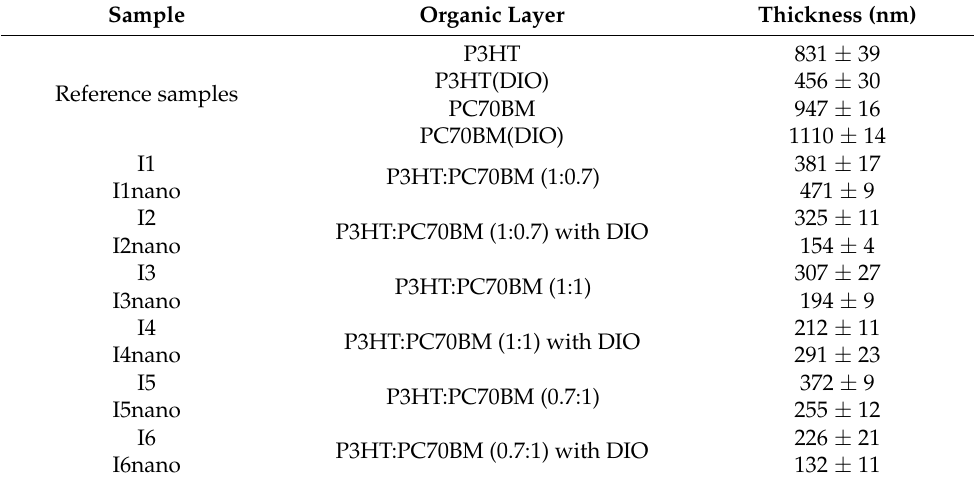
Table 3. Thickness of the organic layers deposited by